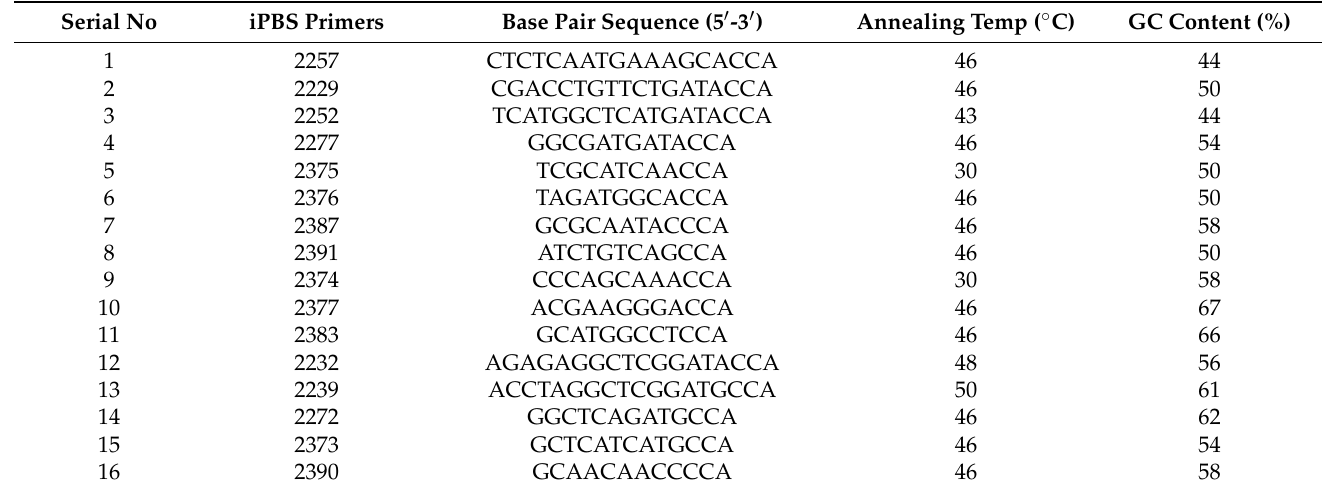
Table 2. List of 16 inter-primer binding site (iPBS) retrotransposon primers with their sequence